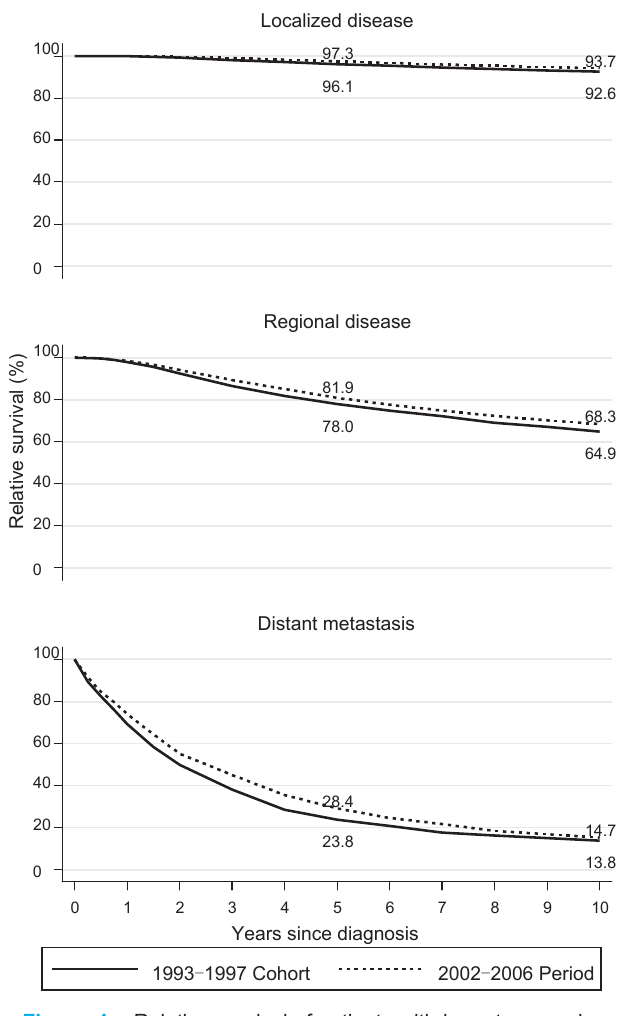
Figure 4. Relative survival of patients with breast cancer by disease